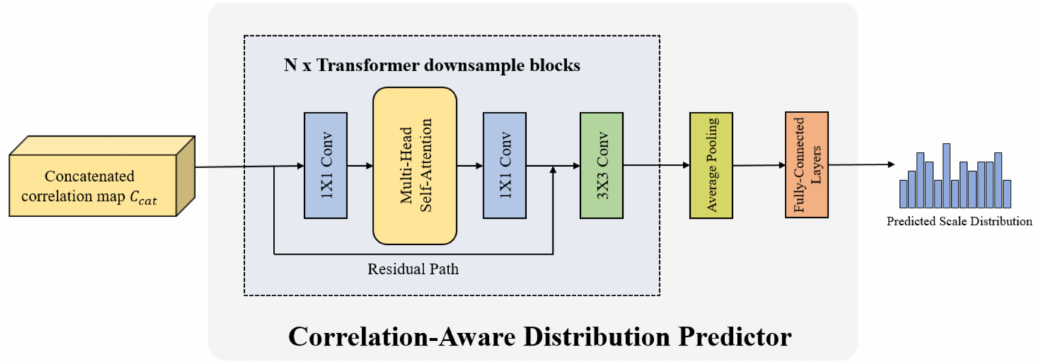
Figure 6. Correlation-aware Distribution Predictor (CADP)